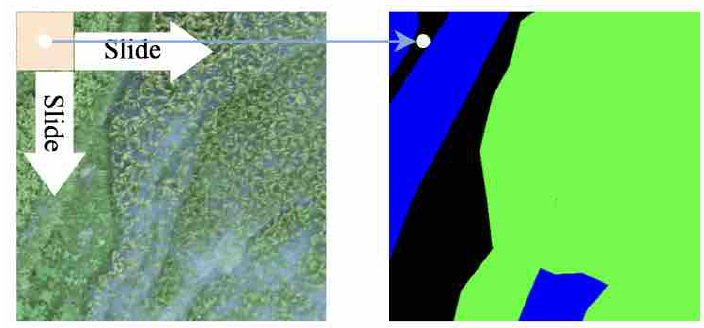
Figure 7. An illustration of the image classification-based method for crop